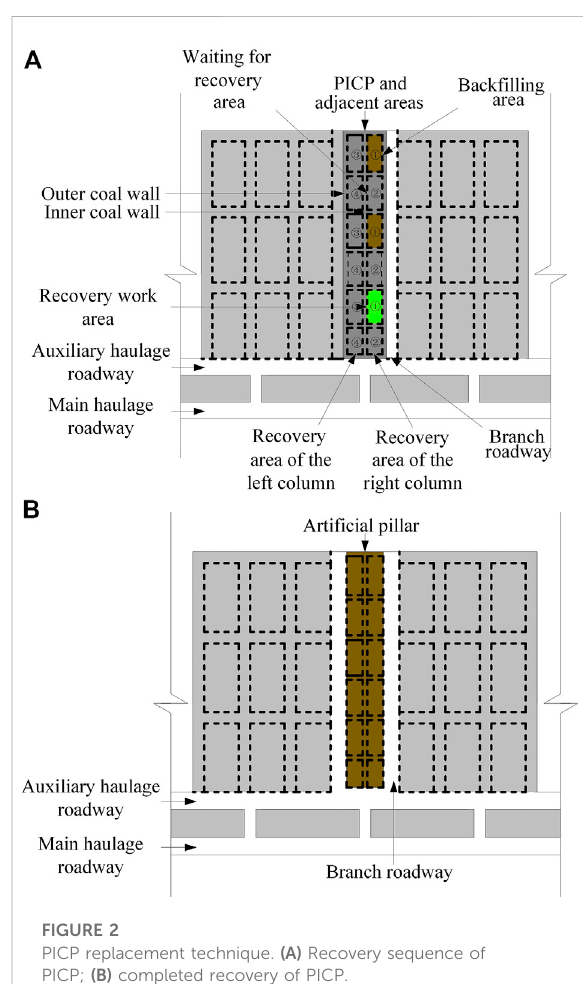
FIGURE 2 PICP replacement technique. (A) Recovery sequence of PICP; (B) completed recovery of